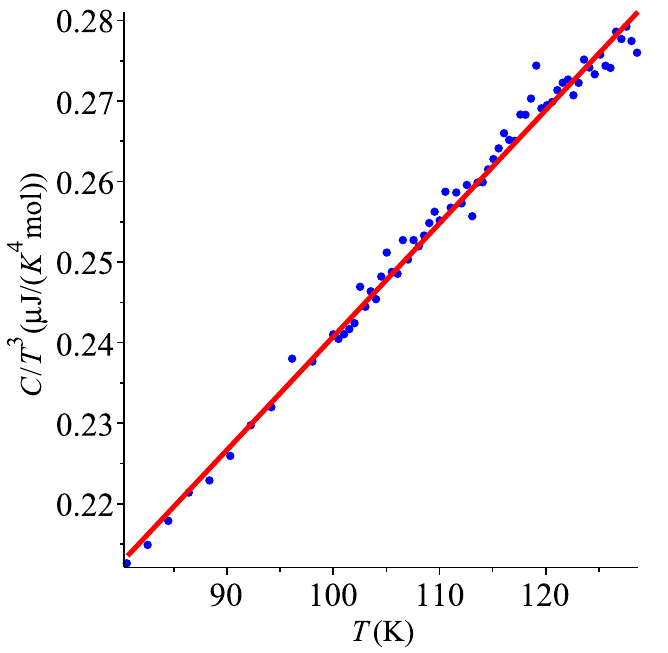
Figure 4. Specific heat of a 48.1 mg natural diamond, unpublished data for Ref. 47